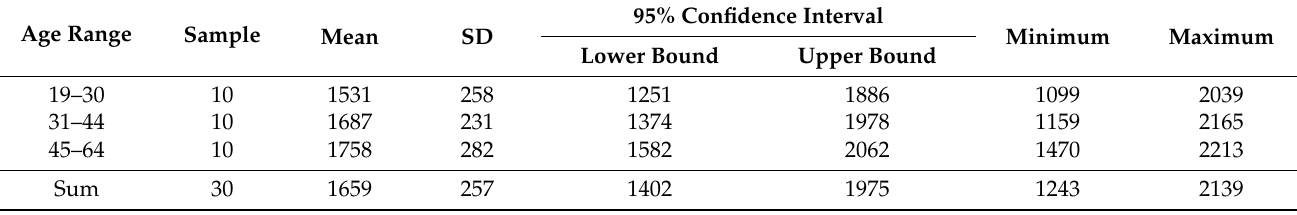
Table 7. Descriptive statistics of the time spent on wayfinding tasks for three different age groups.